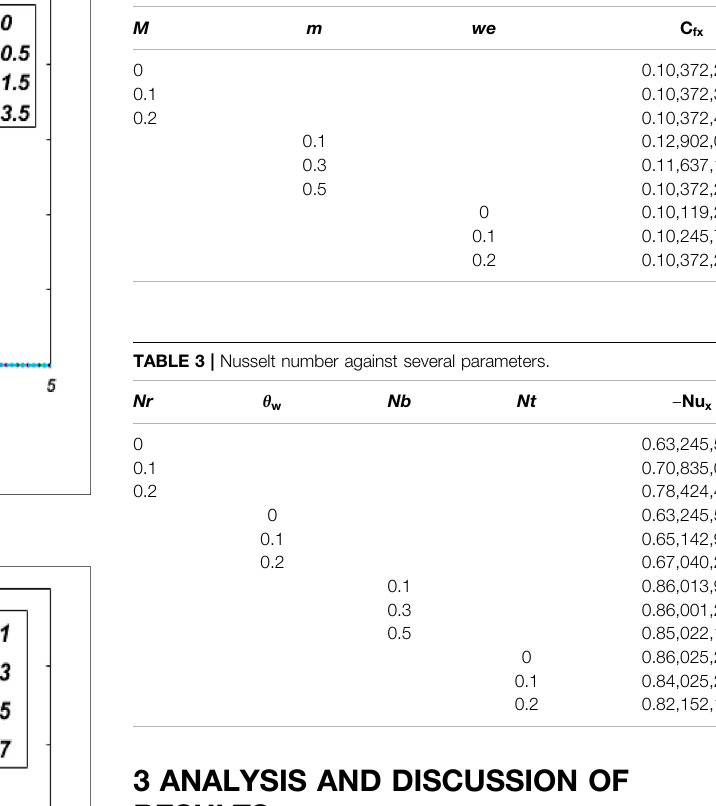
TABLE 2 | Skin friction against several parameters.